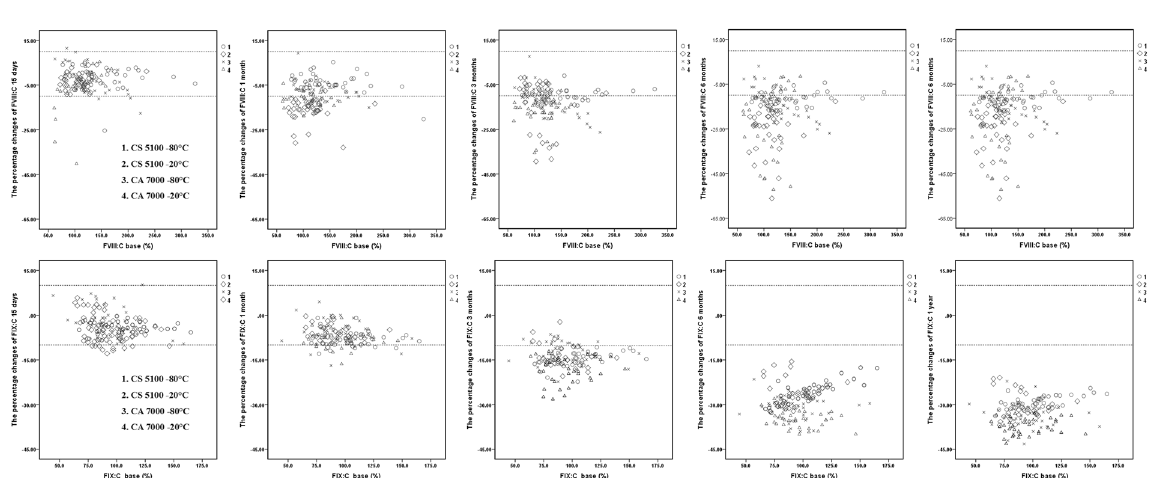
Figure 4. Percent changes of TT in samples stored for 15 days, 1 month, 3 months, 6 months, and 1 year and detected by the CS5100 and CA7000 systems. 1: Samples stored at − 80 °C and analysed by the CS5100 system; 2: samples stored at − 20 °C and analysed by the CS5100 system; 3: samples stored at − 80 °C and analysed by the CA7000 system; 4: samples stored at − 20 °C and analysed by the CA7000 system. The two dotted lines in the figures represent plus or minus 10% changes.